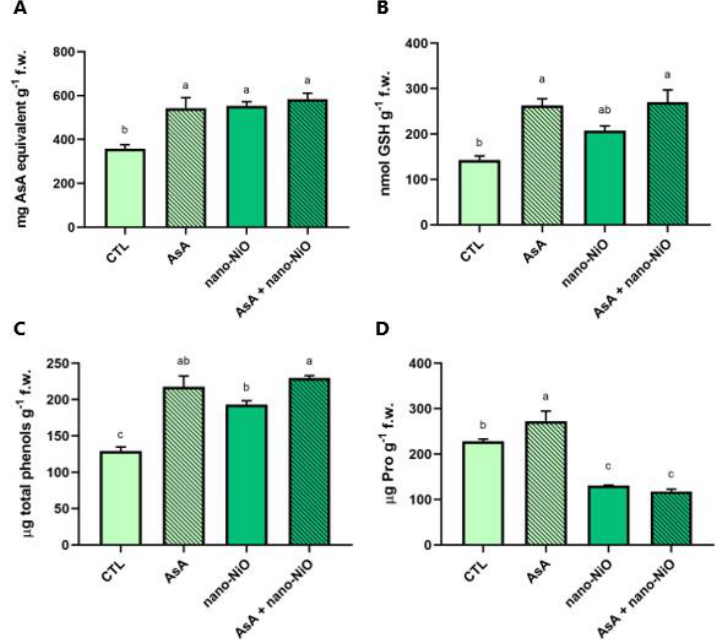
Figure 5. Effects of nickel oxide nanomaterials (nano-NiO; 30 mg L −1 ) and/or ascorbate (AsA; 150 mg L −1 ) on the total antioxidant capacity (TAC; A), content of glutathione (GSH, B), content of total phenols (C), and content of proline (Pro; D) in the shoots of in vitro grown tomato plantlets. Data presented are mean ± SEM (n ≥ 3) (f.w.: fresh weight). Different letters above bars indicate significant statistical differences between treatments at p ≤ 0.05.